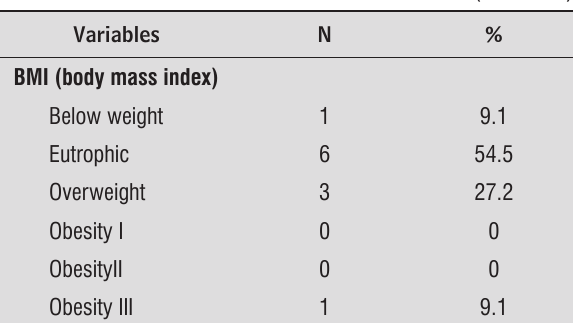
Table 1 - Characteristics of individuals with sleep disor- ders,